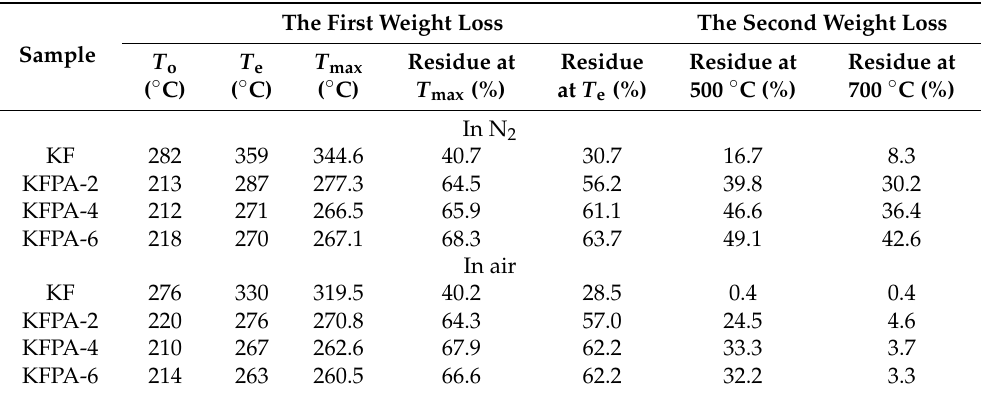
Figure 7. TG and DTG curves of KF and phosphorylated KF samples prepared at various PA dosages (PA 2, 4, and 6 g, 150 °C, and 90 min) in nitrogen ( a ) and air ( b ). Table 1. TG data of KF and phosphorylated KF samples prepared at various PA dosages (PA 2, 4, and 6 g, 150 °C, and 90 min).